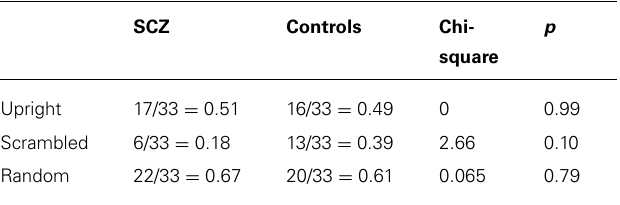
Table 2 | Proportion of participants in Experiment 3 with response accuracies that were less than 1.0 in the upright and random walker conditions and greater than chance in the scrambled walker condition.